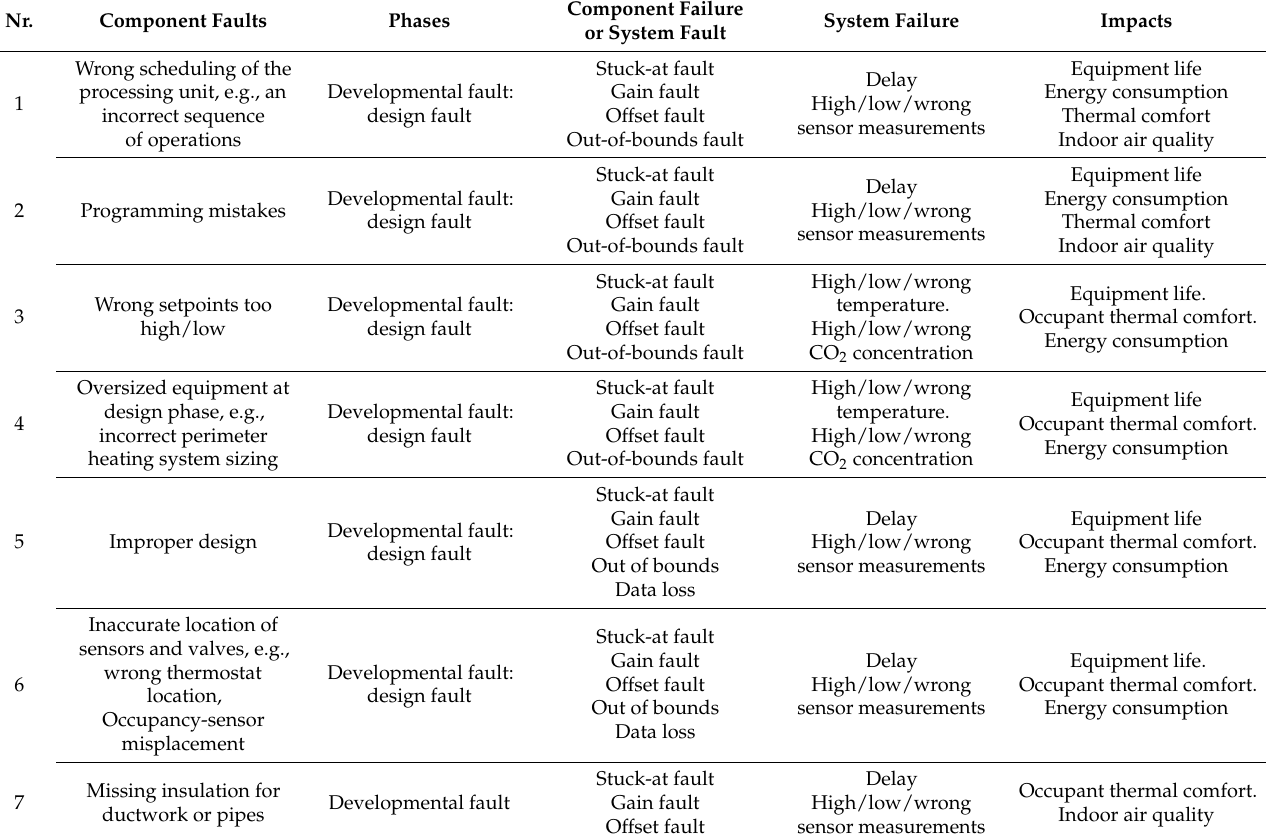
Table 2. Fault propagation examples in HVAC systems